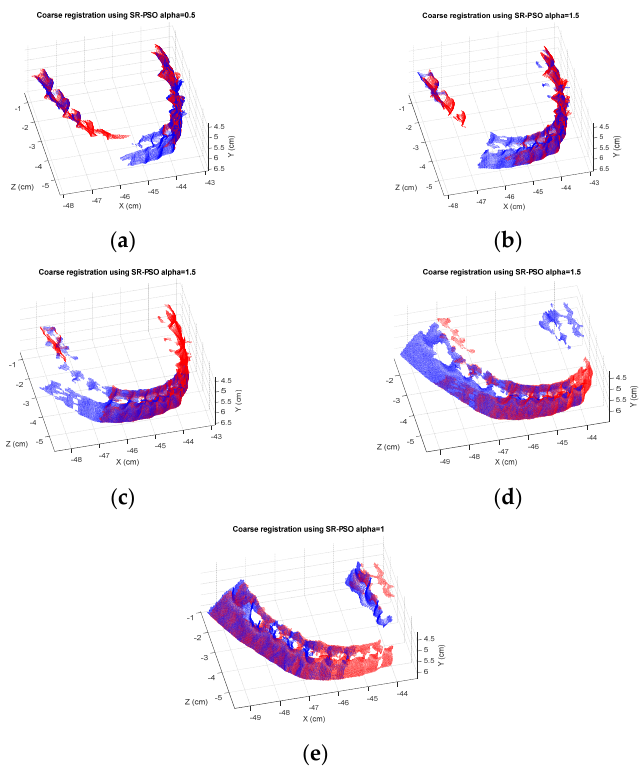
Table 10. MSE of the final registration of six consecutive views (micrometer 2 ) for the orthodontic- tooth model (the best value is in bold).